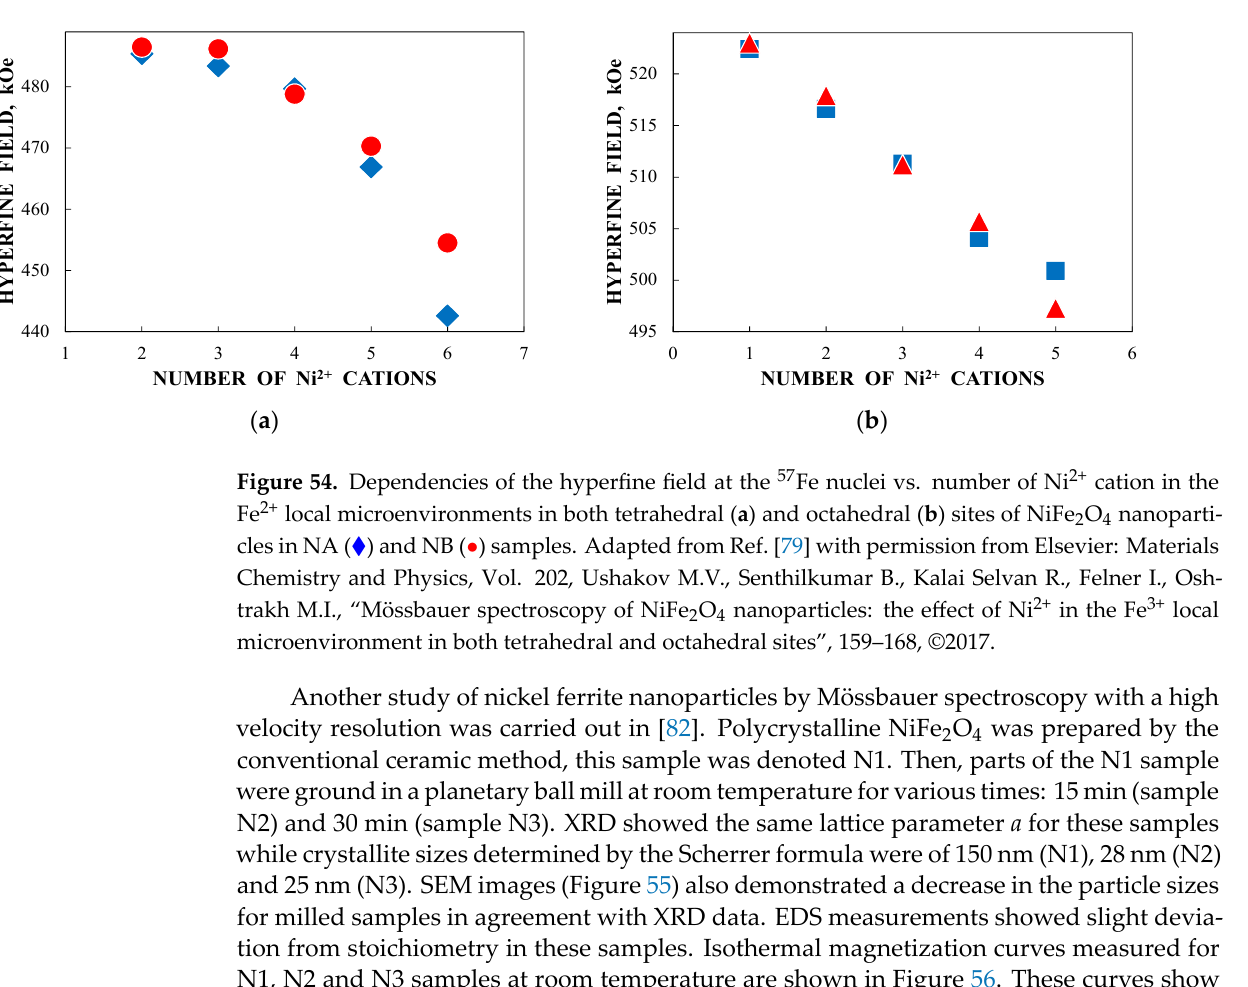
trakh M.I., “Mössbauer spectroscopy of NiFe 2 O 4 nanoparticles: the effect of Ni 2+ in the Fe 3+ local microenvironment in both tetrahedral and octahedral sites”, 159–168, ©2017. Another study of nickel ferrite nanoparticles by Mössbauer spectroscopy with a high velocity resolution was carried out in [82]. Polycrystalline NiFe 2 O 4 was prepared by the conventional ceramic method, this sample was denoted N1. Then, parts of the N1 sample were ground in a planetary ball mill at room temperature for various times: 15 min (sample N2) and 30 min (sample N3). XRD showed the same lattice parameter a for these samples while crystallite sizes determined by the Scherrer formula were of 150 nm (N1), 28 nm (N2) and 25 nm (N3). SEM images (Figure 55) also demonstrated a decrease in the particle sizes for milled samples in agreement with XRD data. EDS measurements showed slight deviation from stoichiometry in these samples. Isothermal magnetization curves measured for N1, N2 and N3 samples at room temperature are shown in Figure 56. These curves show that the saturation magnetic moment decreases for the milled samples N2 and N3 due to a decrease in particle size and due to the appearance of small paramagnetic components. Hysteresis loops were observed for samples N2 and N3 only as well as the coercive force was found increased with increasing the milling time: − 1.1 kOe (N2) and − 1.3 kOe (N3).